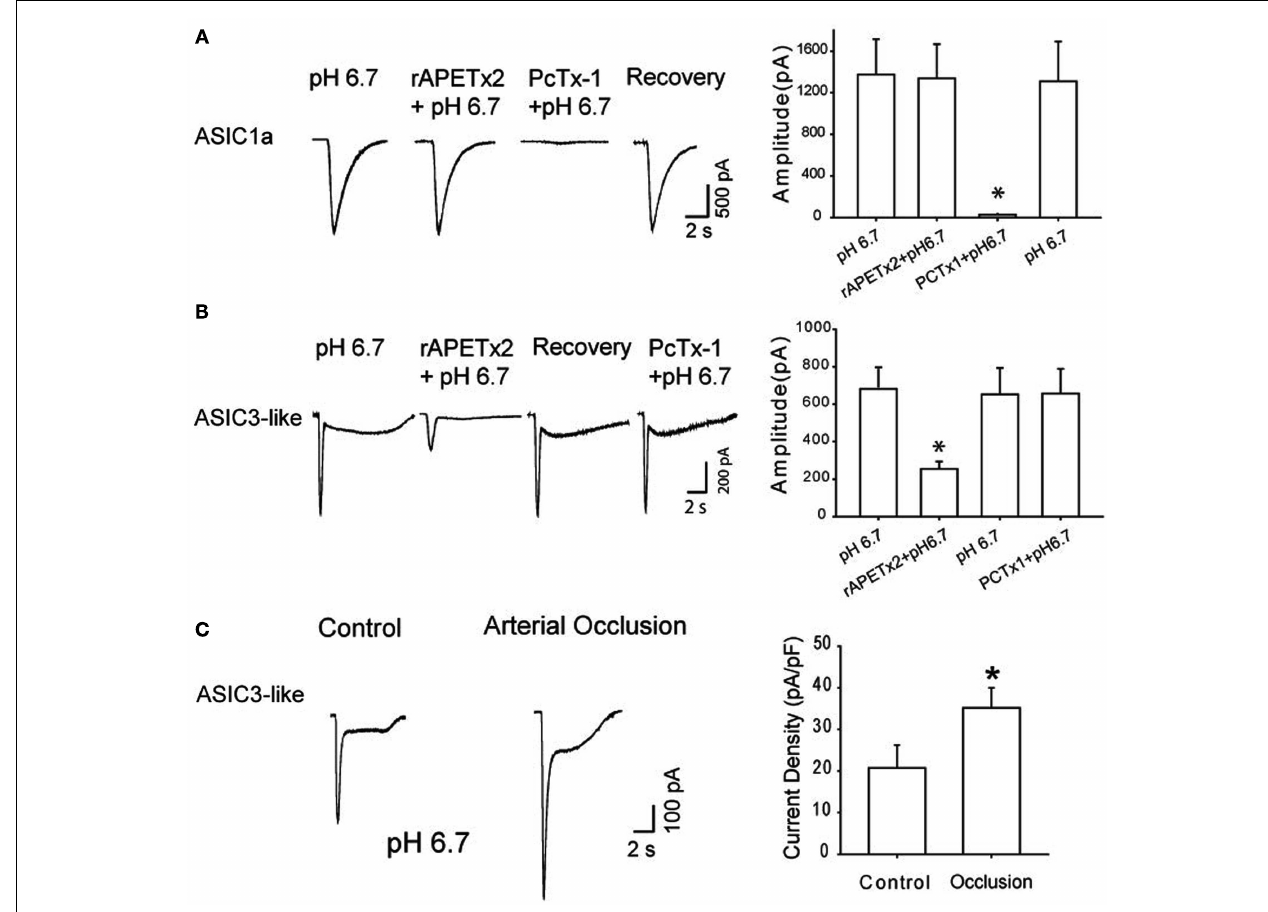
FIGURE 4 | (A,B) Toxins PcTx1 and rAPETx2 were used as antagonists to specifically block ASIC1a and to ASIC3-like currents evoked by pH 6.7 in DRG neurons innervating the hindlimb muscles.Toxin PcTx1 (20nM) significantly inhibited current responses induced by pH 6.7 in DRG neurons exhibiting ASIC1a currents. However, rAPETx2 had no significant effects on this type of current in DRG neurons. Similarly, a prior application of rAPETx2 (1 µ M) significantly attenuated peak amplitudes of currents evoked by pH 6.7 in DRG neurons that displayed ASIC3-like